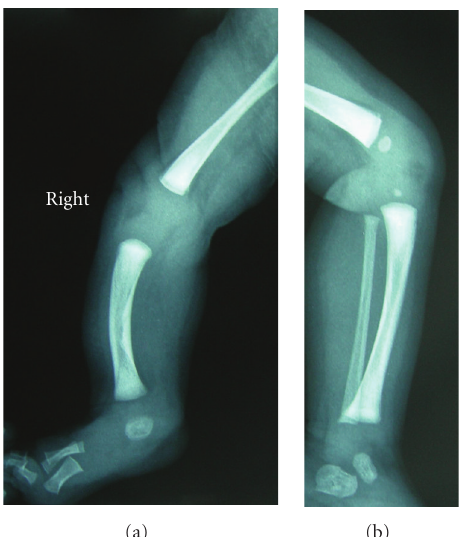
Figure 4: Radiograph showing absence of right fibula and shortening and bowing of right tibia at the 7th postnatal